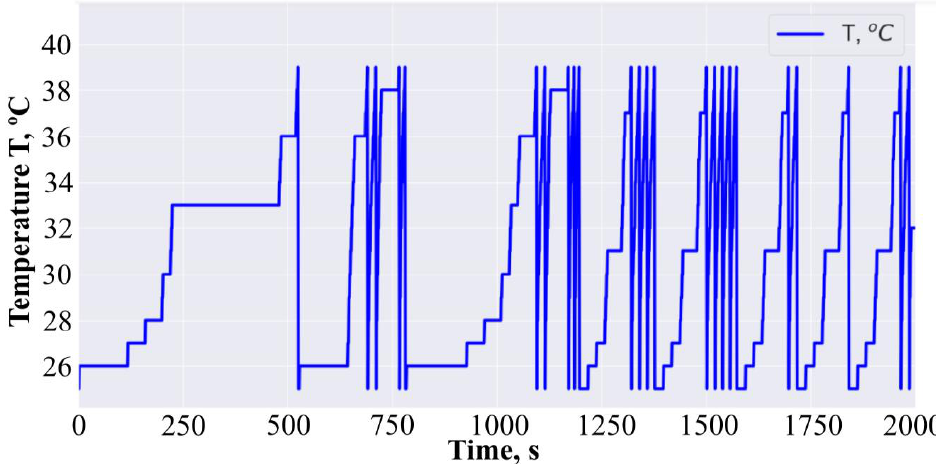
Figure 17. Simulation of temperature of the solar cell during first 2000 s.